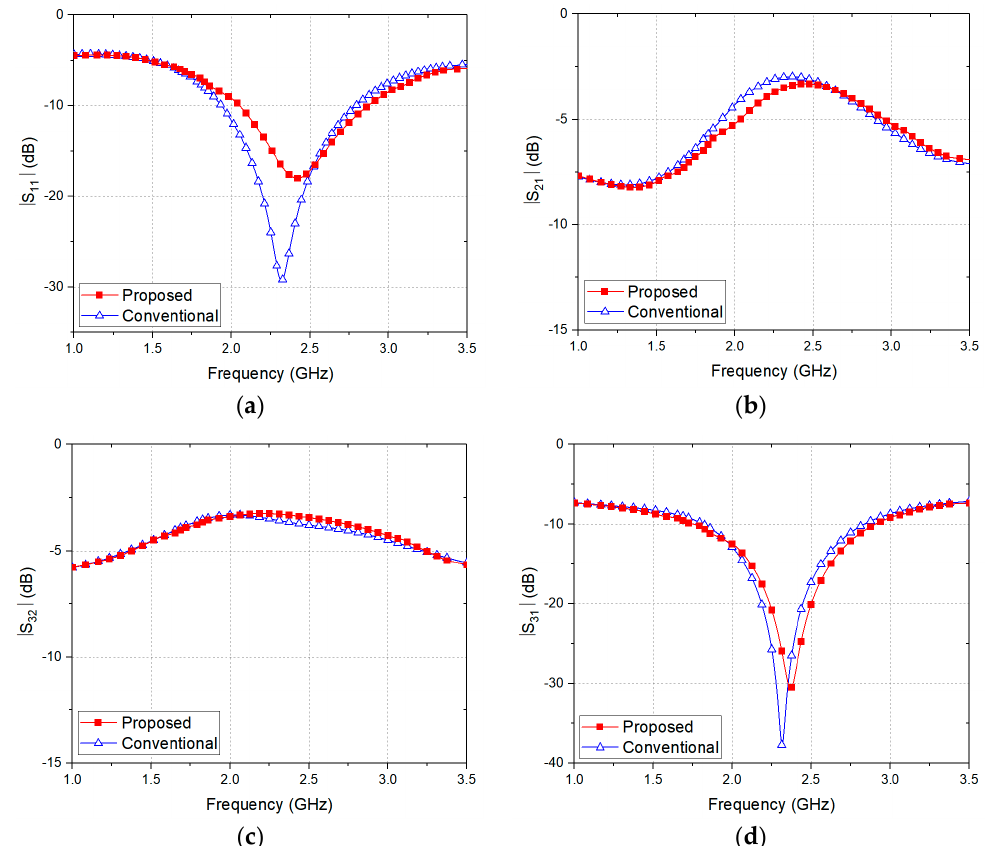
Figure 5. Simulated S -parameters of the proposed and conventional quasi-circulators using 2.45 GHz asymmetric and symmetric branch-line couplers, respectively: ( a ) | S 11 | denotes the return loss at the Tx port; ( b ) | S 21 | denotes propagation gains in the Tx path; ( c ) | S 32 | denotes propagation gains in the Rx path; ( d ) | S 31 | denotes the Tx leakage isolation between the Tx and Rx ports.